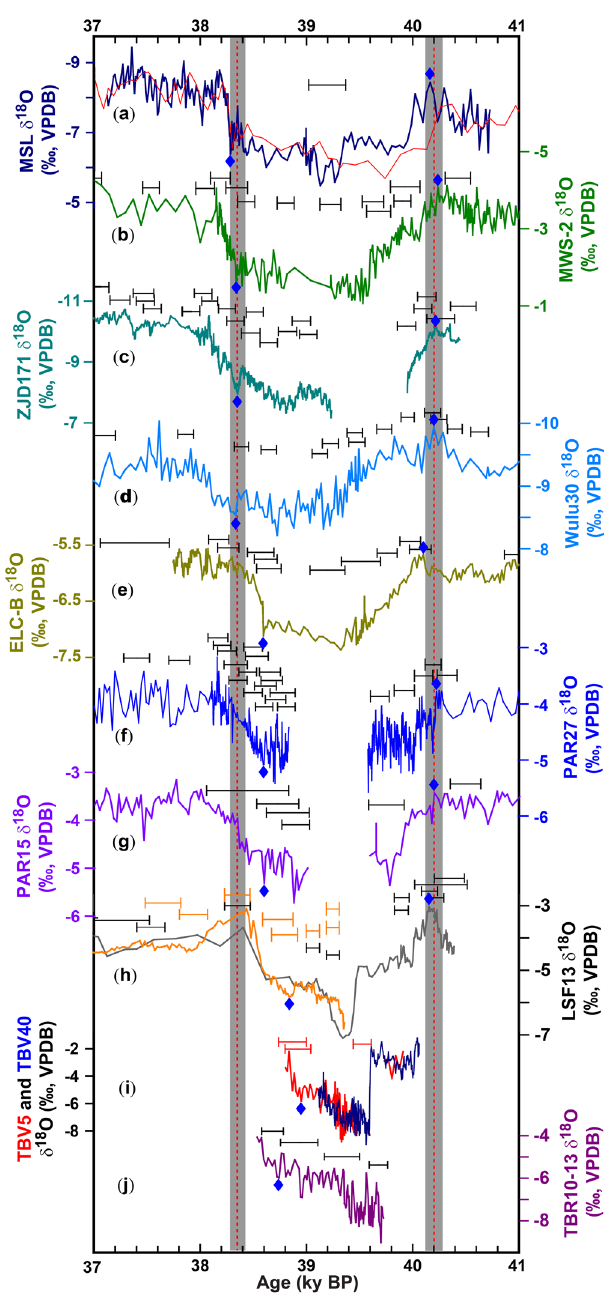
Hulu (MSL) chronology is based on the previous study 38 and the error bar depicts the typical uncertainty. Two vertical dashed lines depict the initial onset of CS4/SAS4 at 40.20 ± 0.08 ky BP and initial CS4 termination at 38.34 ± 0.07 ky BP, respectively. Vertical dark gray bars show the uncertainties. Blue diamonds show the initial onset and termination points determined directly based on the Method